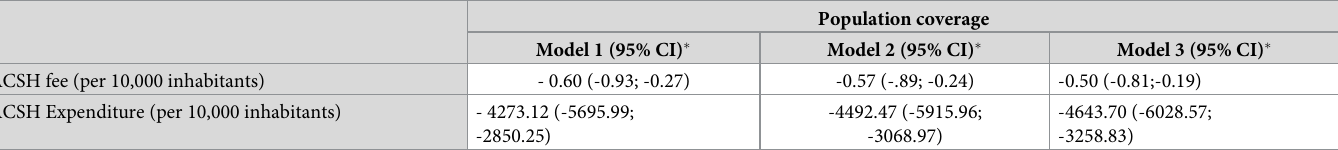
Table 3. Impact of the Family Health Strategy on ACSHs and hospital expenses covered by the SUS, Para´,